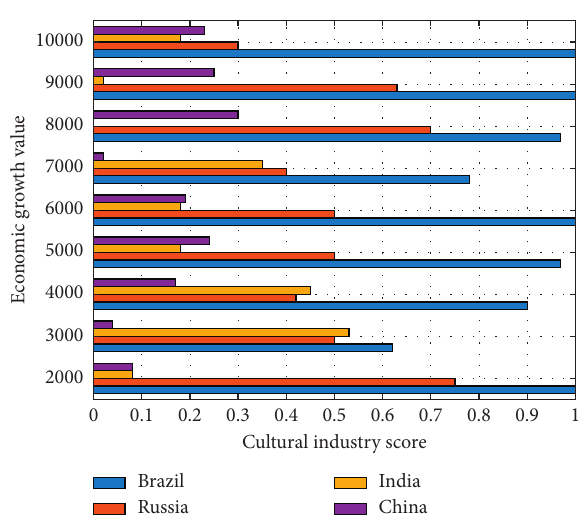
Figure 5: Changes in economic growth competitiveness scores of cultural industries.